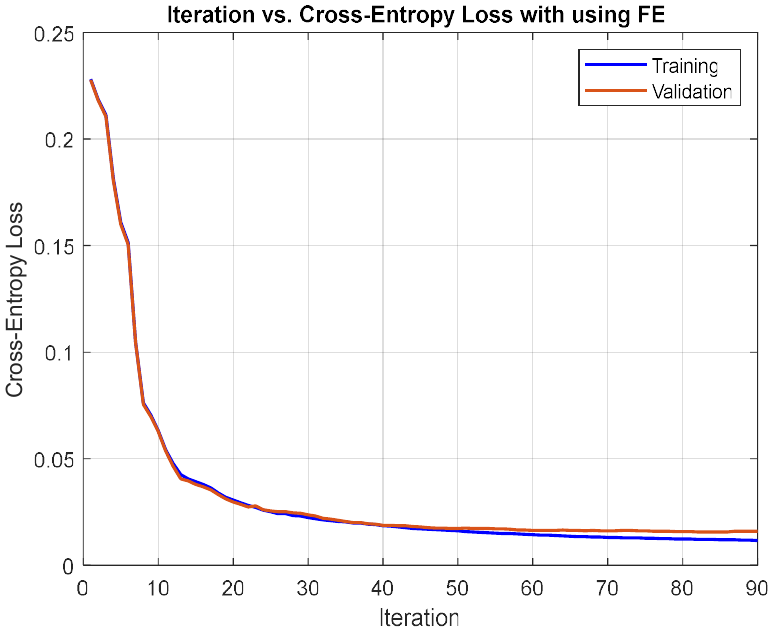
Figure 4. Iteration vs. cross-entropy loss for features extraction of noisy signals with length 1600 and one hidden layer.